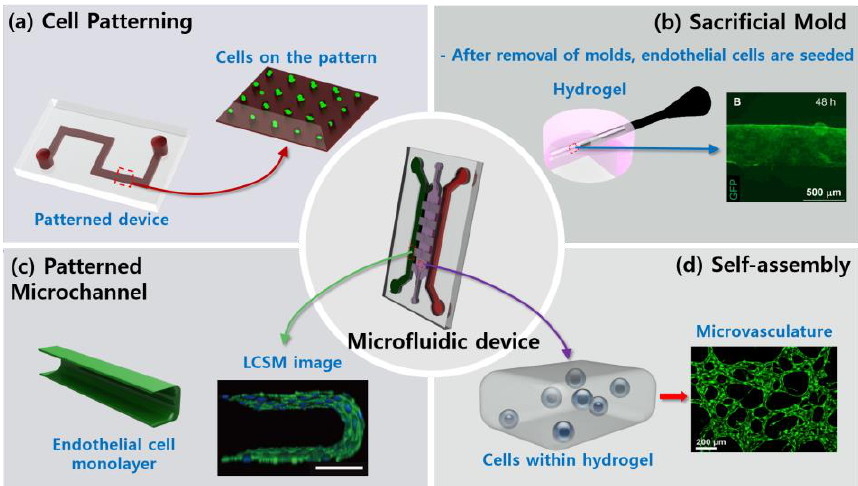
Figure 1. Schematic representation of fabrication methods. ( a ) Endothelial cells (ECs) (green) are cultured on the designed pattern or the specified membrane. ( b ) After removal of sacrificial molds, ECs (green) are seeded [30]. ( c ) ECs form monolayer alongside the hydrogel. Immunostaining of vascular endothelial cadherin (VE-cadherin, green) and nuclei (blue) confirm the functionality of the vessel [16]. Scale bar 100 µm. ( d ) ECs (green) are seeded within the hydrogel, and microvasculature is then formed through vasculogenesis [23]. Reproduced with permission.